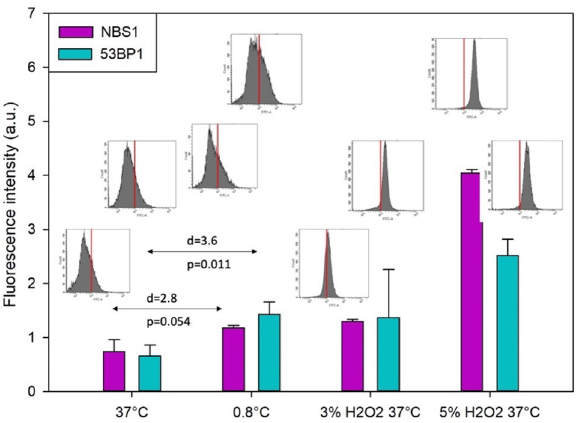
Figure 4. Oxidative stress in U2OS cells (levels of dihydrorhodamine 123) exposed to hypothermia and two concentrations of H 2 O 2 , a.u. arbitrary units. Results represent mean values from 3 experiments with U2OS- NBS1 and U2OS-53BP1 cells. Error bars represent standard deviations from 3 experiments. Histograms represent results from flow cytometric analyses. Red vertical lines mark the FITC-A level of 10 3 . D values represent Cohen’s d values, p values represent significance level from two-sided Student’s t test, assuming unequal variance. See Fig. 1E for exposure details.